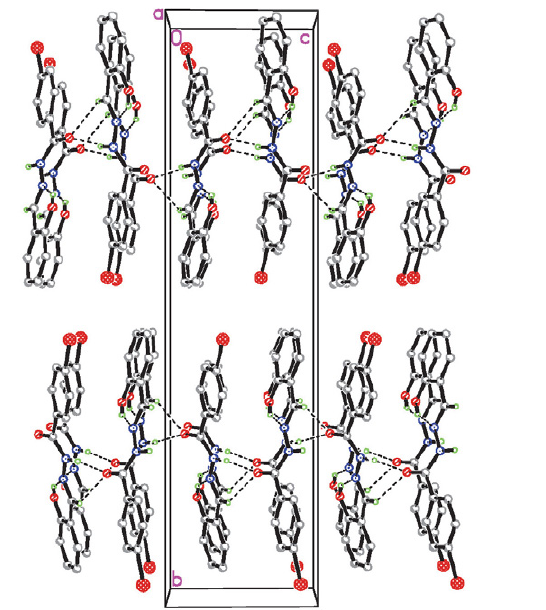
Figure 3. ORTEP plots (30% probability level) and numbering scheme for the